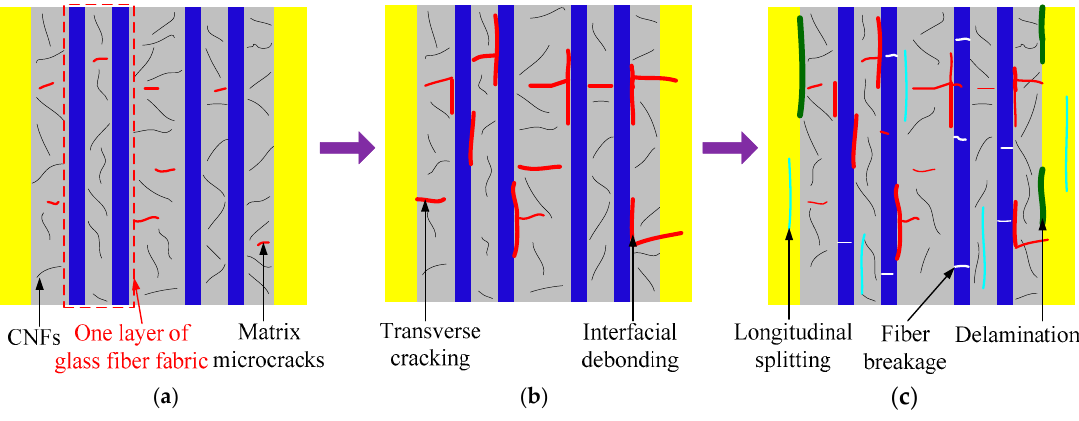
Figure 9. Illustration of the damage evolution of CNF/GFRP laminates during monotonic loading: ( a ) initiation of matrix microcracks; ( b ) transverse cracking and fiber-matrix interfacial debonding; ( c ) longitudinal splitting, delamination and glass fiber